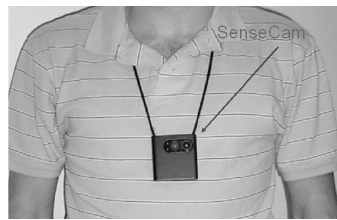
Figure 1. The Microsoft